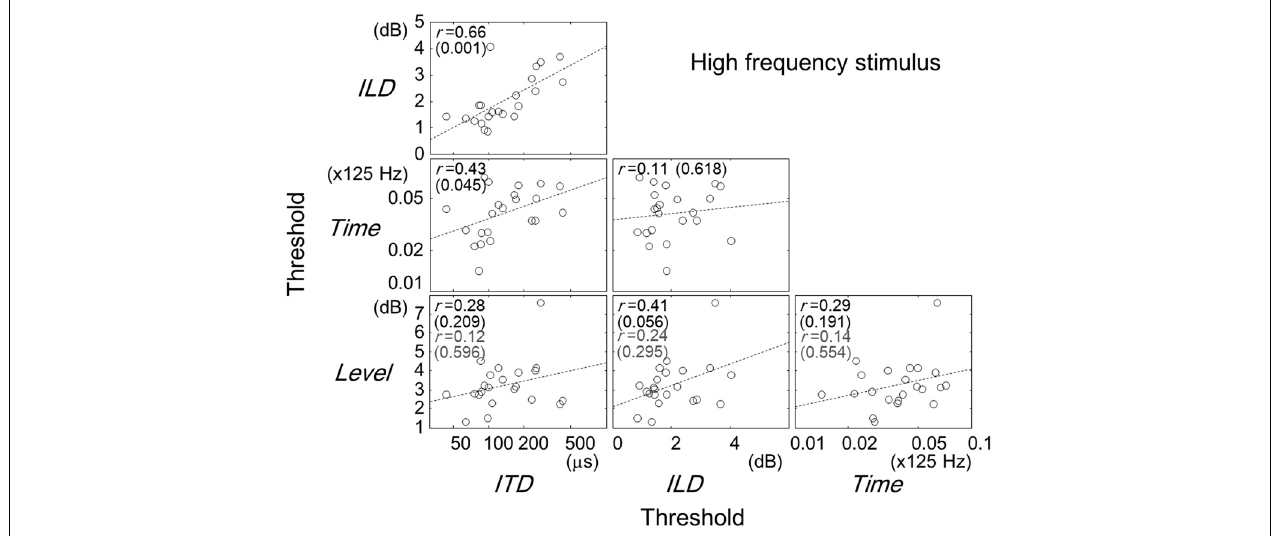
FIGURE 3 | Same as Figure 2 but for the high-frequency stimulus. The correlation coefficients and p -values in gray indicates values when listener 10 was excluded.